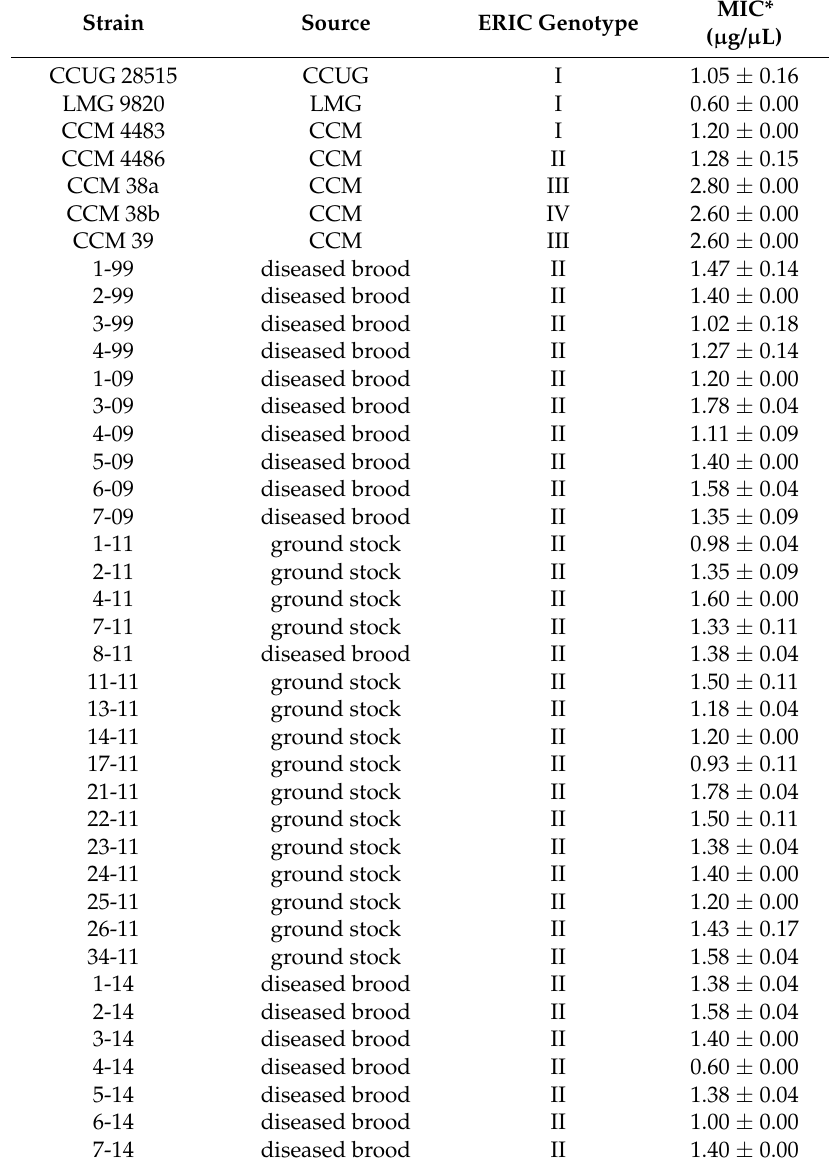
Table 1. P. larvae strains, their characteristics and susceptibility to